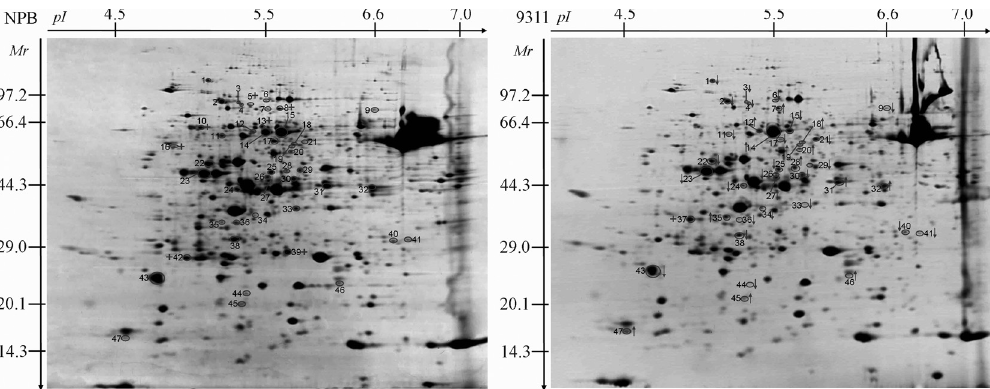
Figure 1 - The proteomic profiles of Nipponbare and 93-11. The protein spots 1 to 47 were identified by MS and database searches. The upward and downward pointing arrows indicate up-regulated and down-regulated proteins in 93-11, respectively. Protein spots unique in this 2-D gel are identified with a plus symbol (+). NPB –